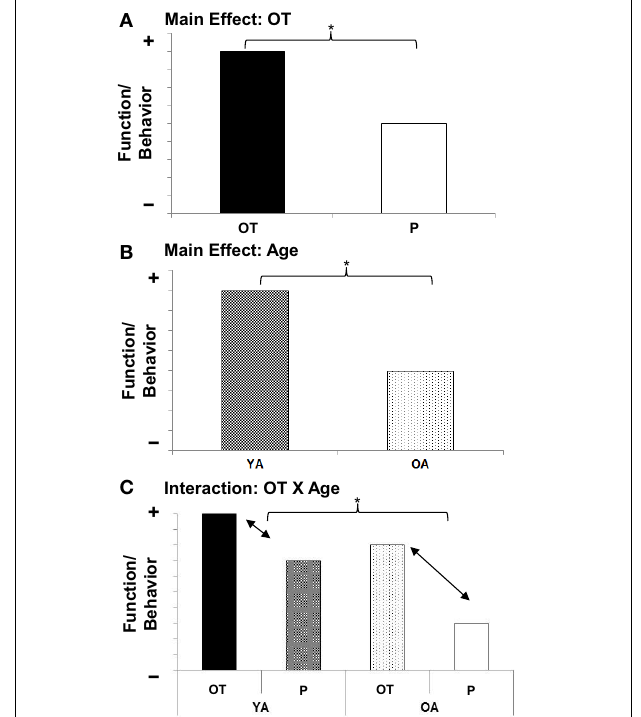
FIGURE 3 | (A) Main effect for Age; (B) Main effect for Oxytocin; (C) Oxytocin X Age interaction effect. Schematic representation of guiding working hypotheses. YA, Young adults, OA, Older adults; OT, Oxytocin, P,